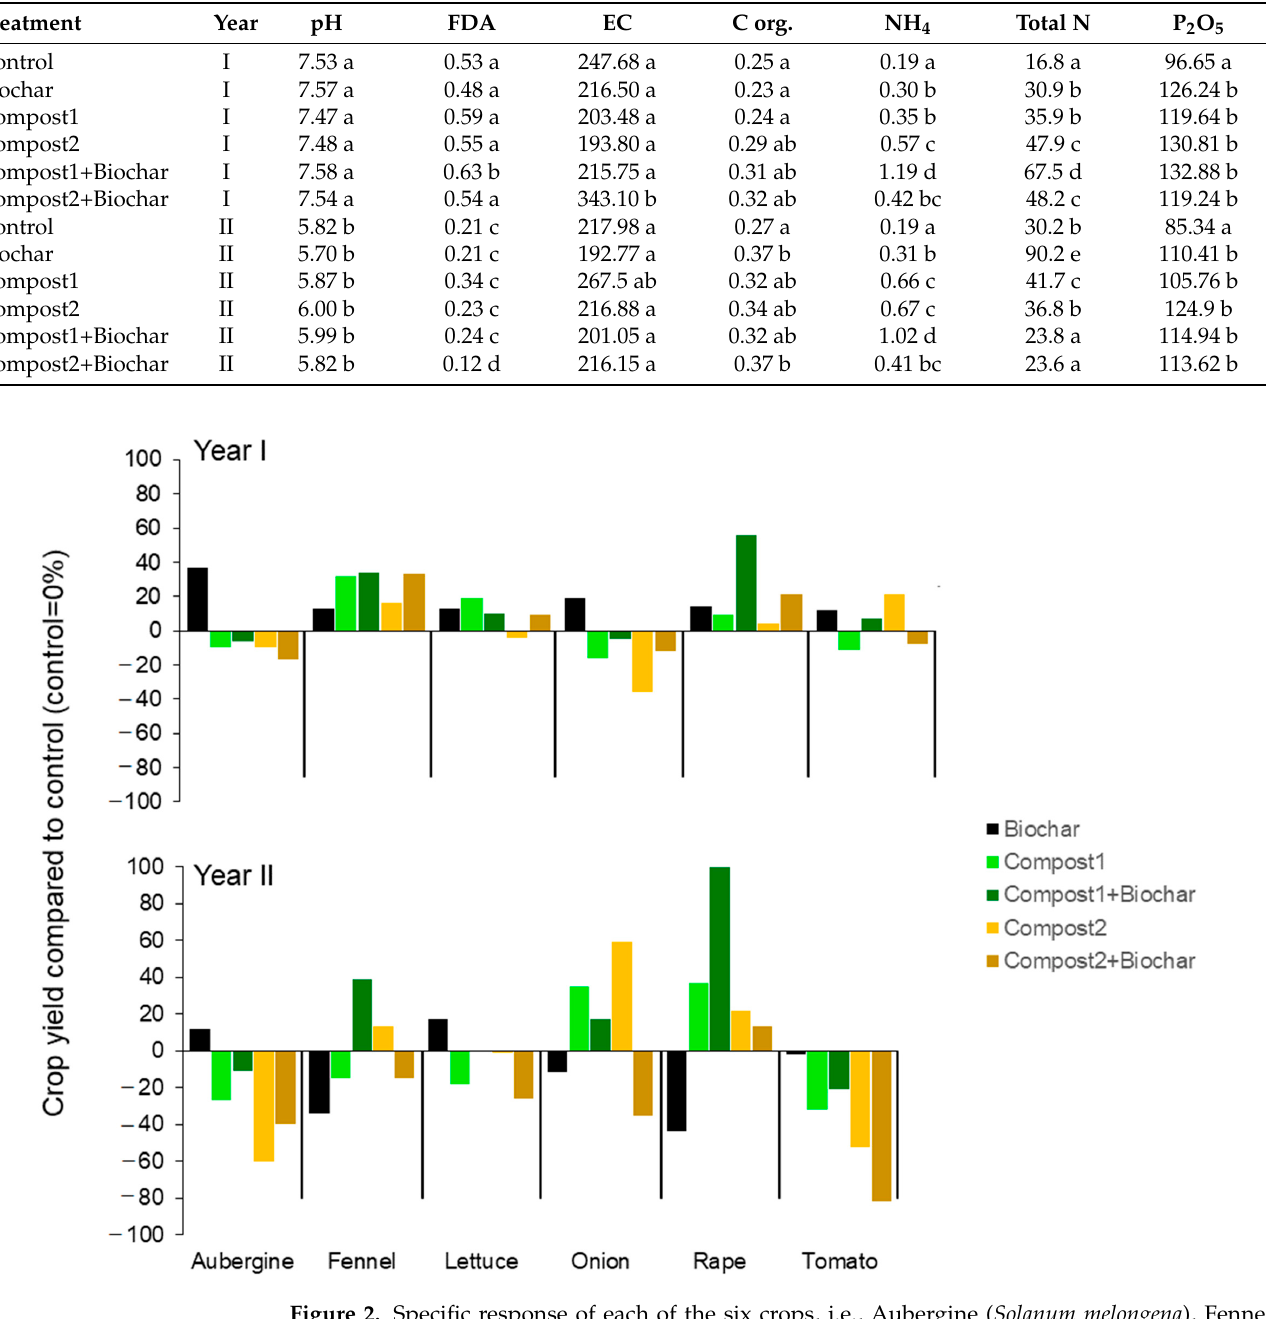
Figure 2. Specific response of each of the six crops, i.e., Aubergine ( Solanum melongena ), Fennel ( Foeniculum vulgare ), Lettuce ( Lactuca sativa ), Onion ( Allium cepa ), Rape ( Cucurbita pepo ), and Tomato ( Lycopersicon esculentum ), used during the experiment while applying each of the five different treatments. Specific response is represented by the crops yield comparing to the control (0%).